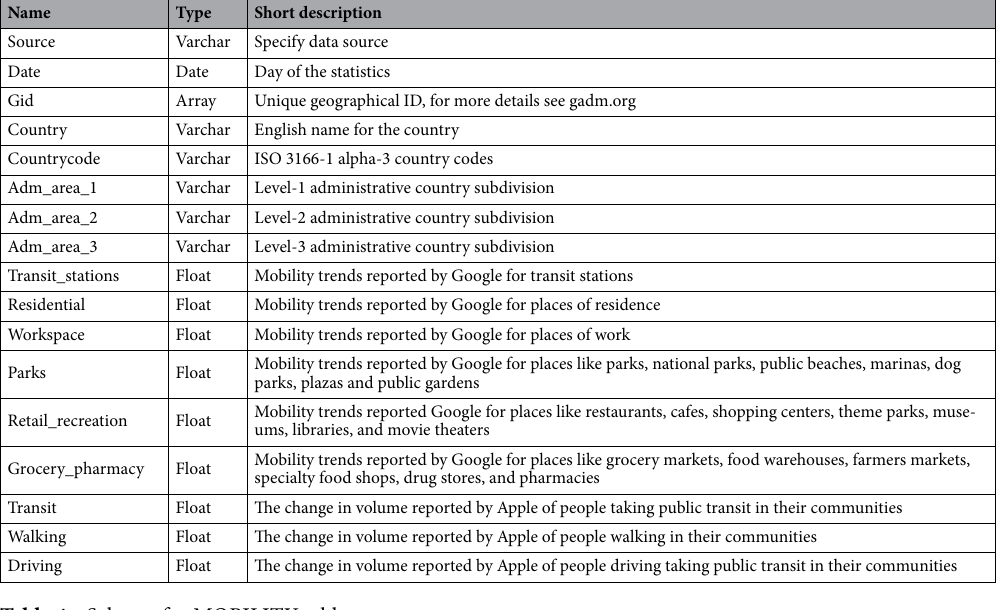
Table 4. Schema for MOBILITY